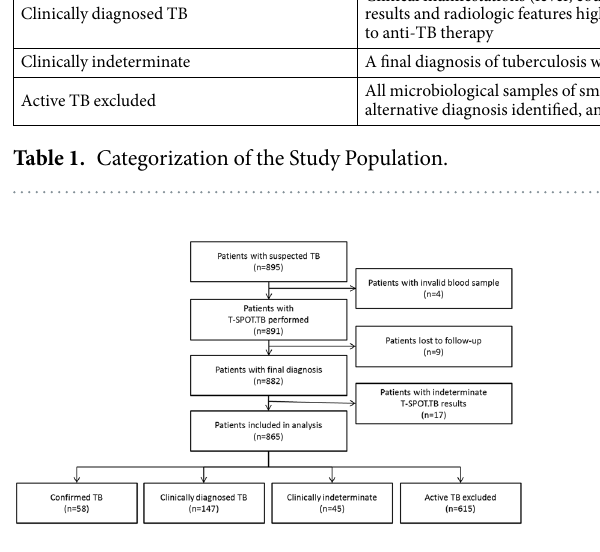
Figure 1. Flowchart of enrollment of patients with suspected